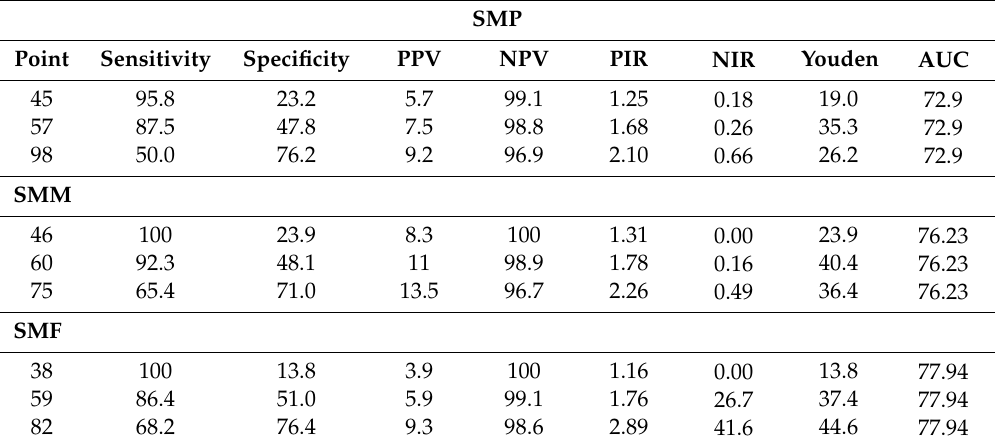
Table 4. Performance evaluation of the models of undiagnosed diabetes mellitus